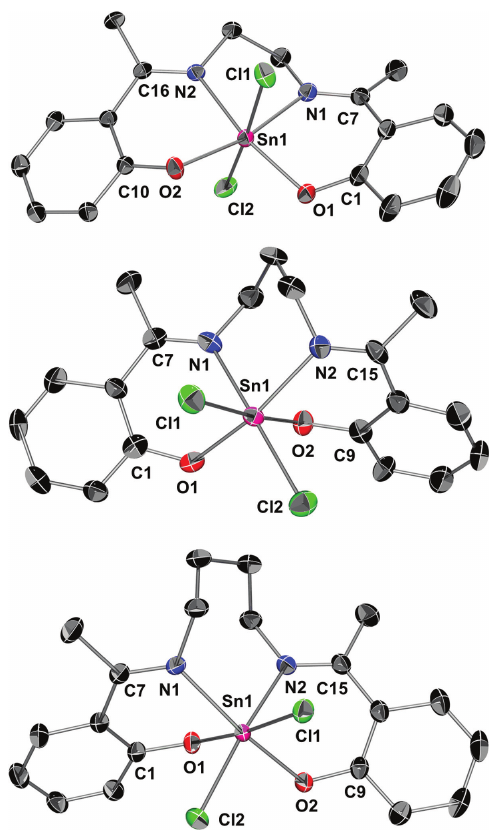
, L 2 SnCl and 2 2 and L 2 SnCl , which 2 2